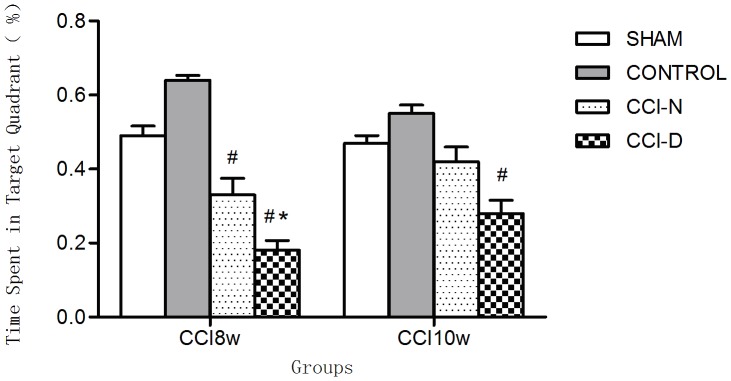
Time spent in the targeted quadrant after 2 weeks of rhGH treatment.Note: * P<0.05 compared to the sham group; # P<0.05 compared to the control group.